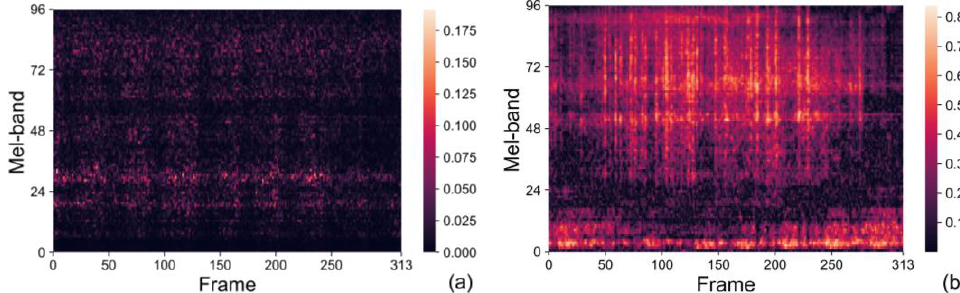
Figure 12. Distance between every two corresponding points of the compared mel-spectrograms in the form of heat map between: ( a ) two similar mel-spectrograms (of toy-car number 67 and toy-car number 221) and ( b ) two dissimilar mel-spectrograms (of toy-car number 67 and toy-train number 74).